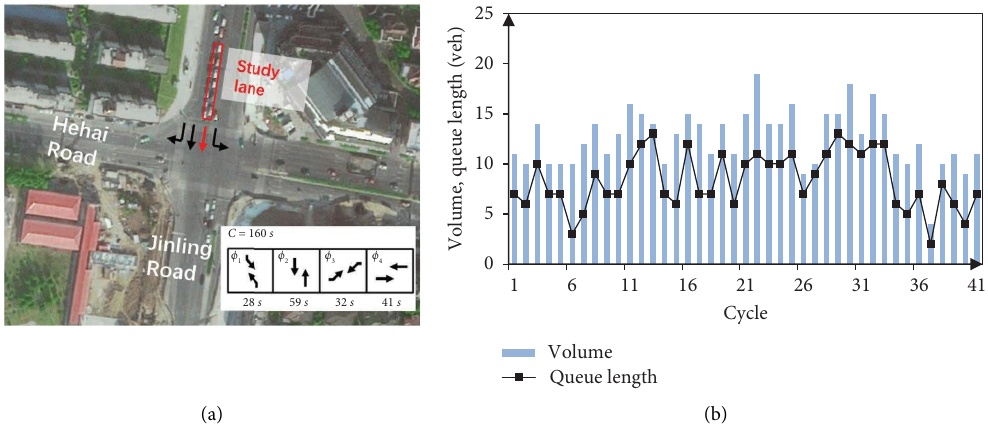
Figure 4: Te study intersection for empirical cases. (a) Study lane. (b) Ground truth of the trafc volume and queue